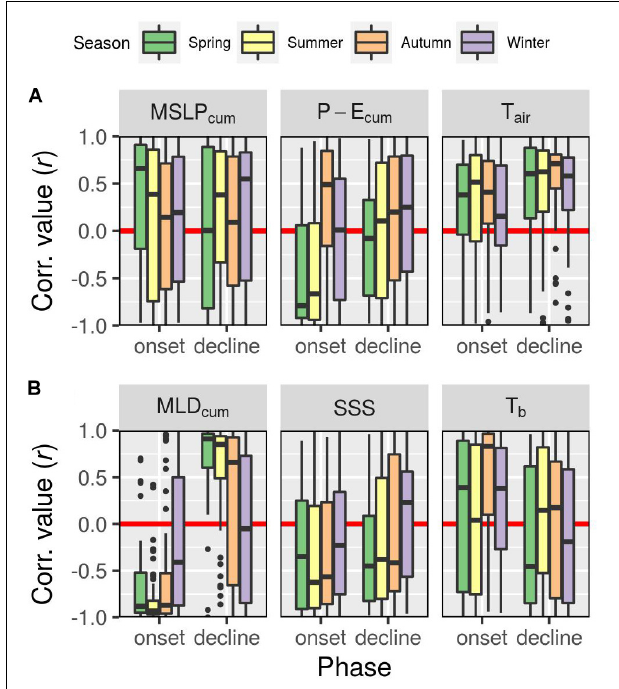
FIGURE 5 | Boxplots showing the range of correlation values ( r ) between SSTa and the top three atmospheric and oceanic variables, grouped by season and marine heatwave (MHW) phase. The horizontal red line shows r = 0, where no correlation is found. The variables are divided into panels (A) atmospheric and (B) oceanic. The center black line in the boxplots is the median value, and the tops and bottoms are the interquartile range (25th – 75th percentiles). The whiskers show all other values falling within 1.5 this interquartile distance, and the black dots are outliers. The further from the red line the center of the boxplots are, the less normal, and therefore more meaningful the relationship with that variable and MHW onset or decline is. The variable abbreviations may be found in Sections “Data” and “Agreement